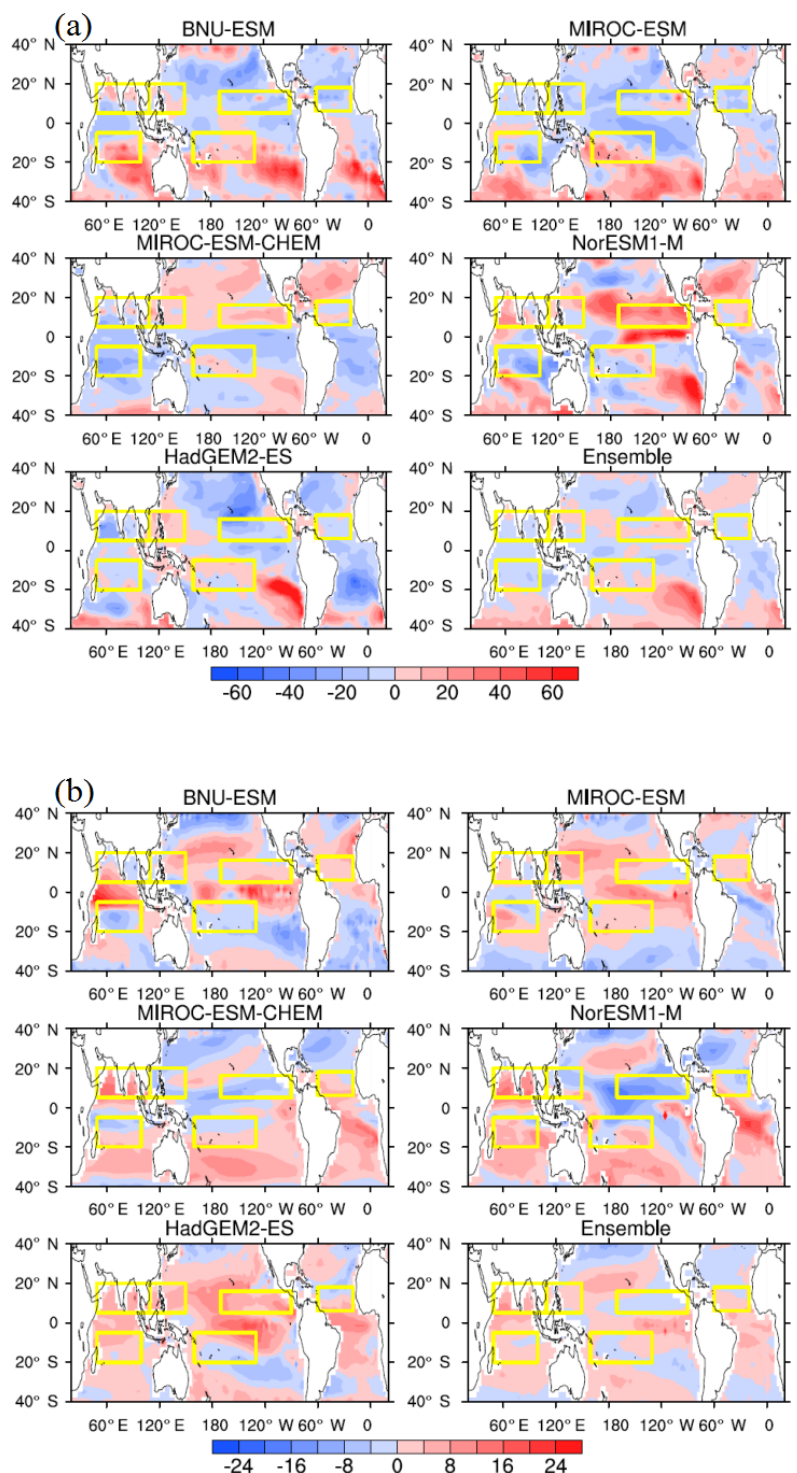
Figure 3. Spatial distribution at each grid point during the appropriate TC season between 2020 and 2069 of the anomaly as a percentage ((GPI G4 − GPI RCP4 . 5 ) / GPI RCP4 . 5 ) for (a) GPI and (b) VI. Yellow rectangles delimit the six TC ocean basins. The Northern Hemisphere TC season is defined as June through November, and the Southern Hemisphere season is defined to be January through